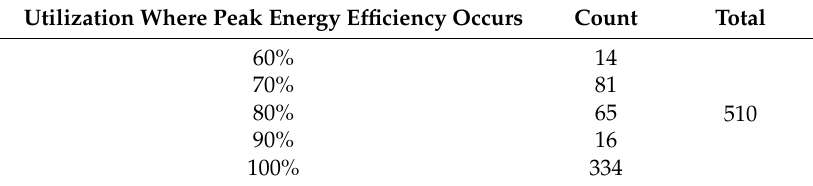
Table 5. Count of utilization where peak energy efficiency occurs.